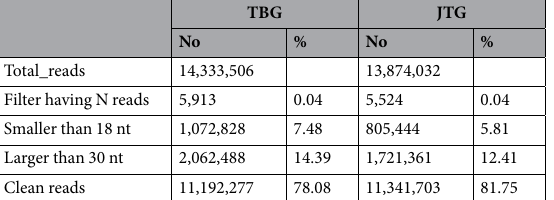
Table 1. Classification of total small RNA tags by RNA-Seq in Tibetan goat (TBG) and Jintang black goat (JTG) ovary libraries.